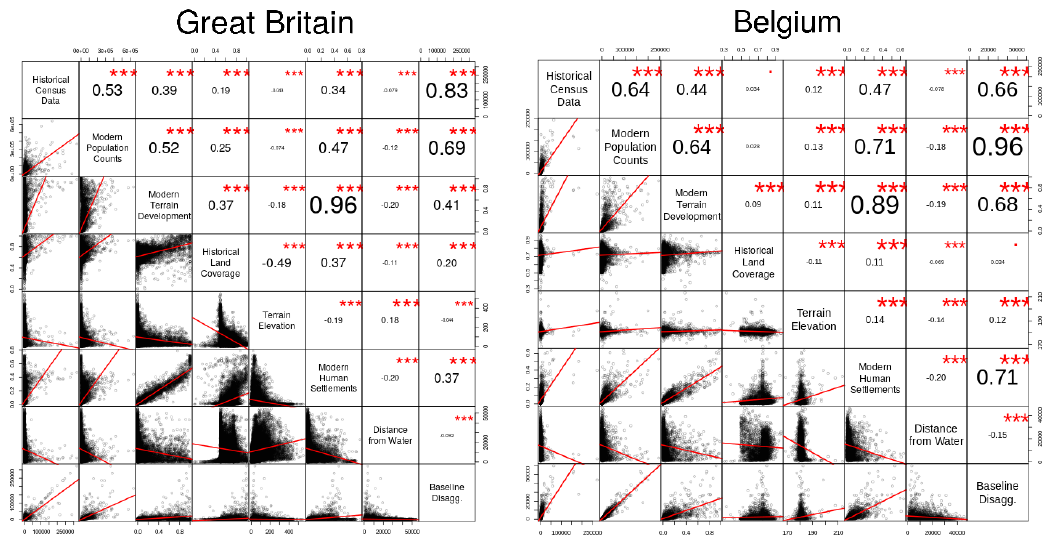
Figure 7. Correlation matrices between the ancillary variables and historical